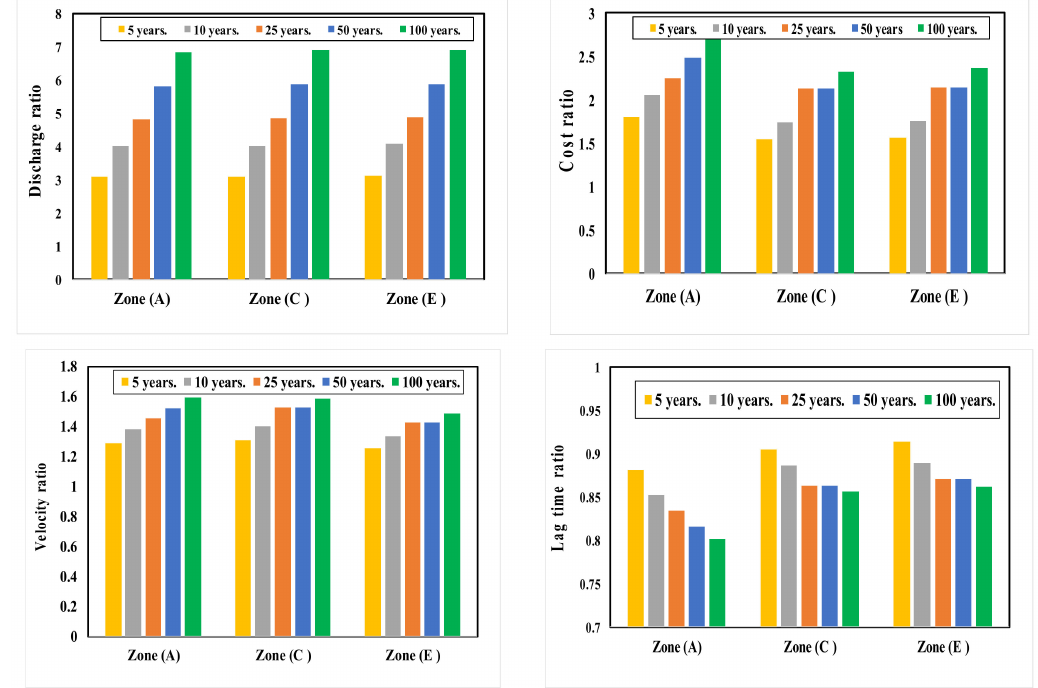
Figure 13. Comparison between discharges, cost, velocity and lag time for zones A, C and E at runo ff coe ffi cient (C = 0.6).